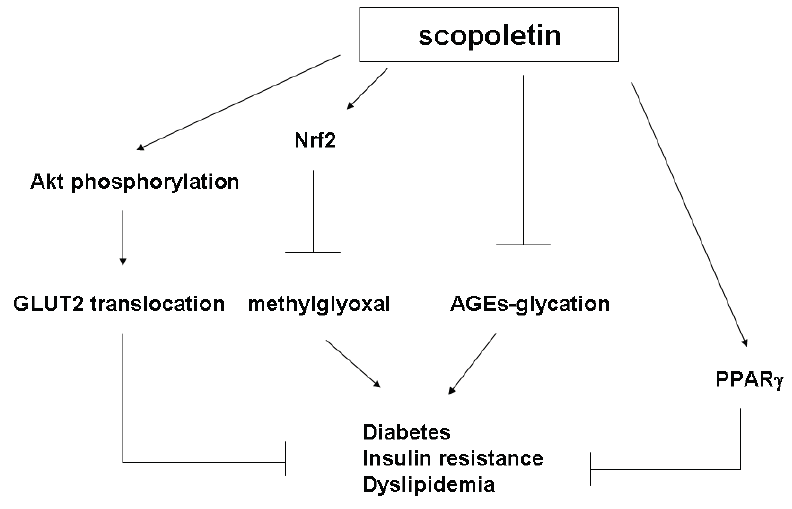
Figure 9. The potential mechanism of scopoletin for diabetes